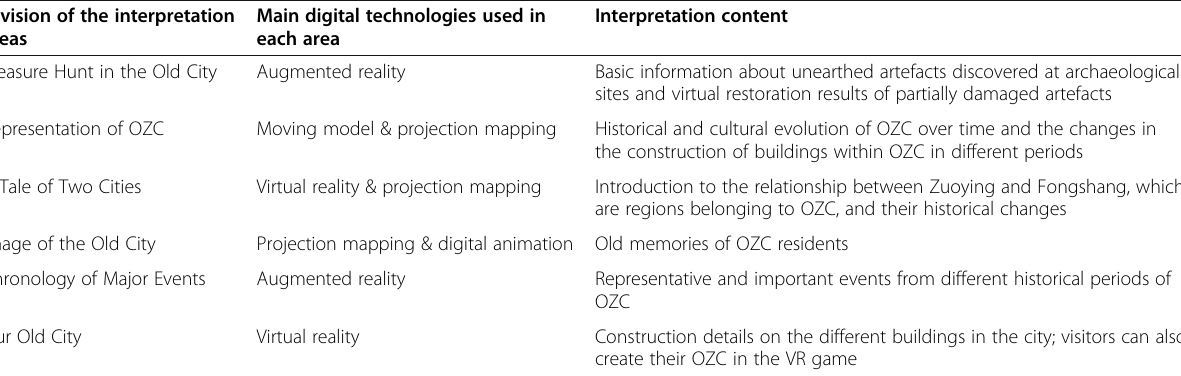
Table 5 Details on the interpretation technologies and content at